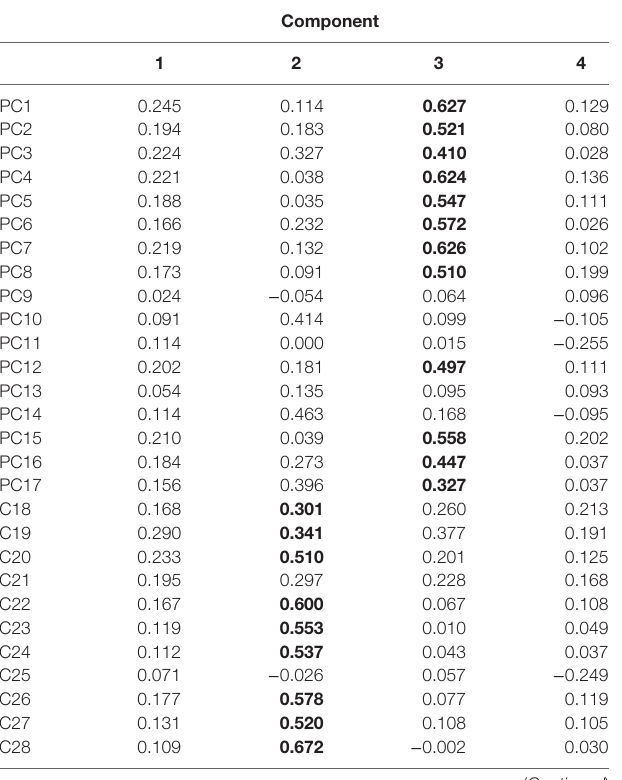
TaBle a3 | Factor structure and factor loadings of ASES Final Form.